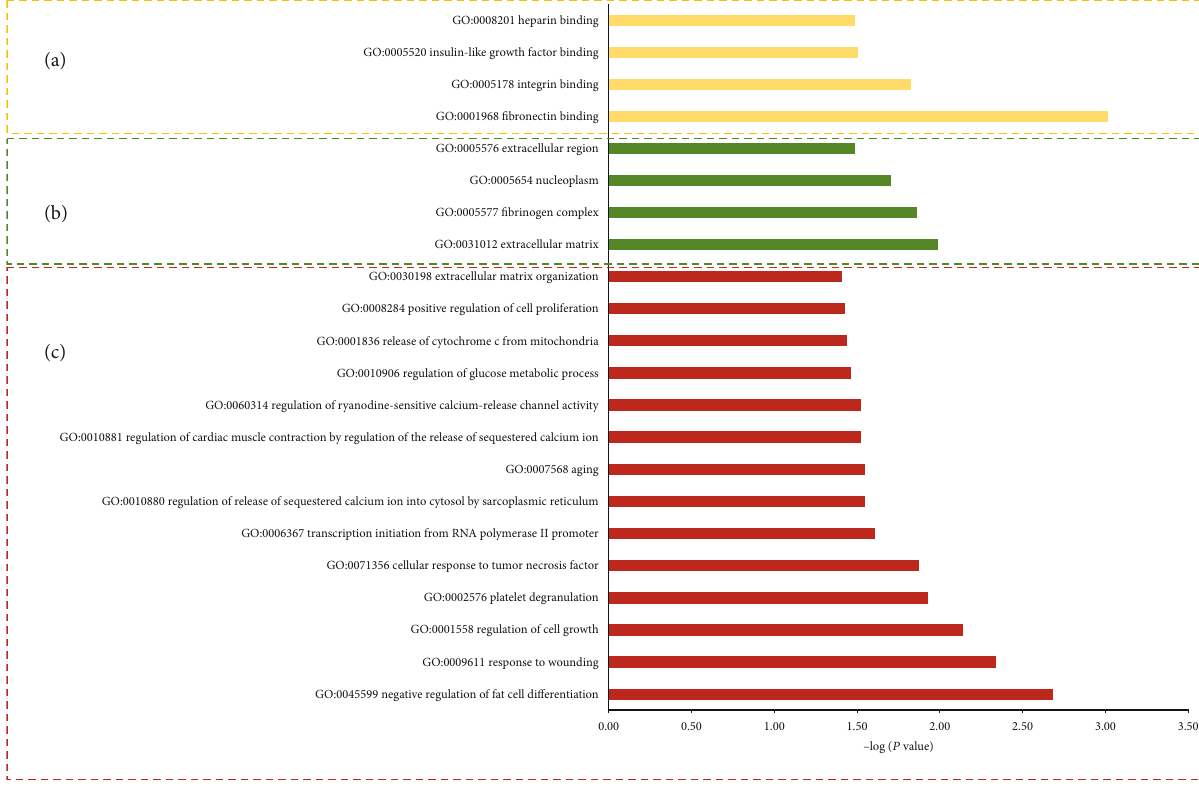
Figure 4: The GO term enrichment analysis on 33 selected DEGs in GC. (a) Thin yellow bars represent molecular function terms. (b) Green bars represent cell component terms. (c) Red bars represent biological